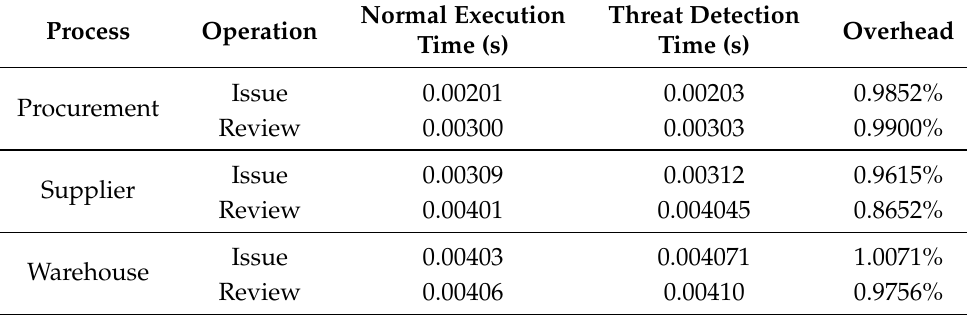
Table 2. Evaluation of internal